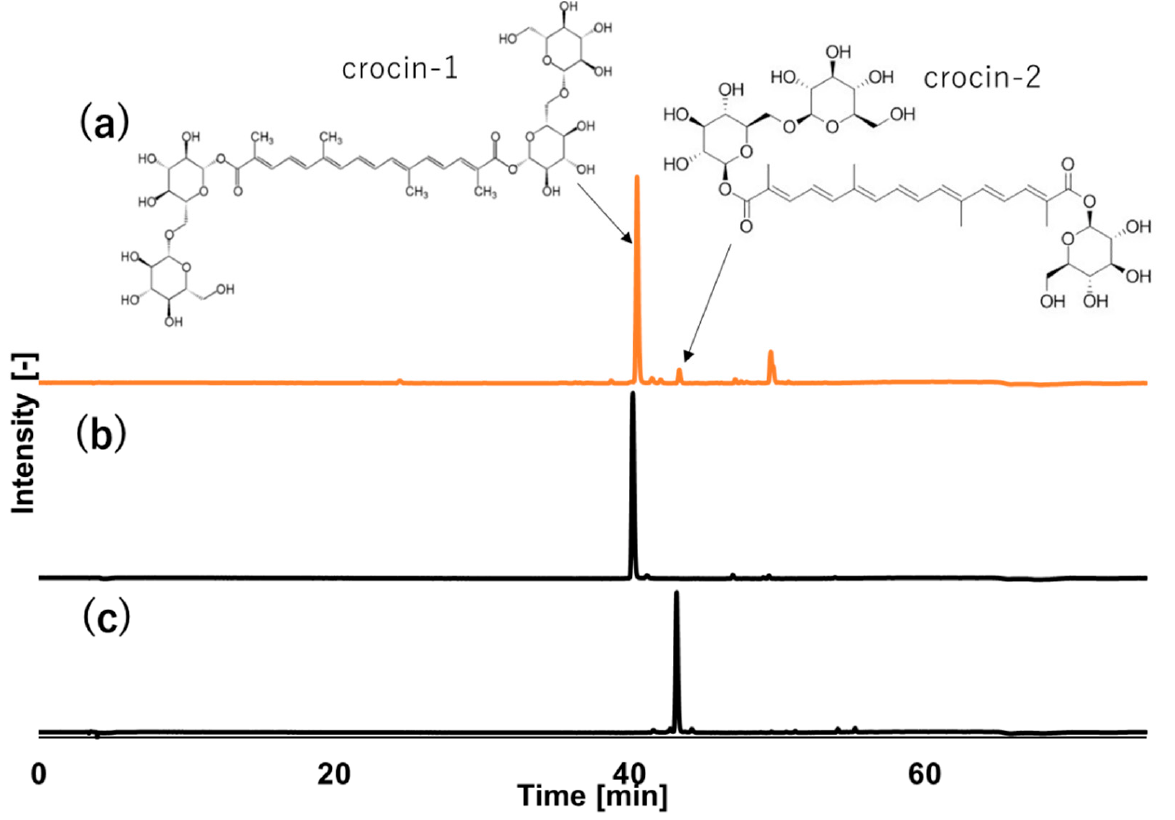
Figure 2. HPLC-UV chromatograms of ( a ) extracted substances from gardenia fruit pulp using liquid CO 2 , 80% ethanol, and ultrasound at 25 °C and 10 MPa; ( b ) standard sample of crocin-1; ( c ) standard sample of crocin-2.